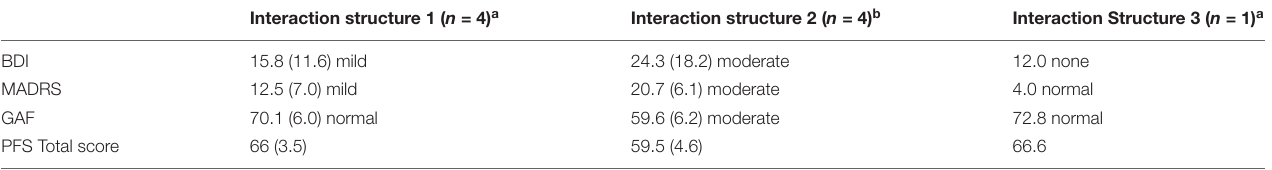
TABLE 7 | Comparison of the three interaction structures in terms of depression and functioning post